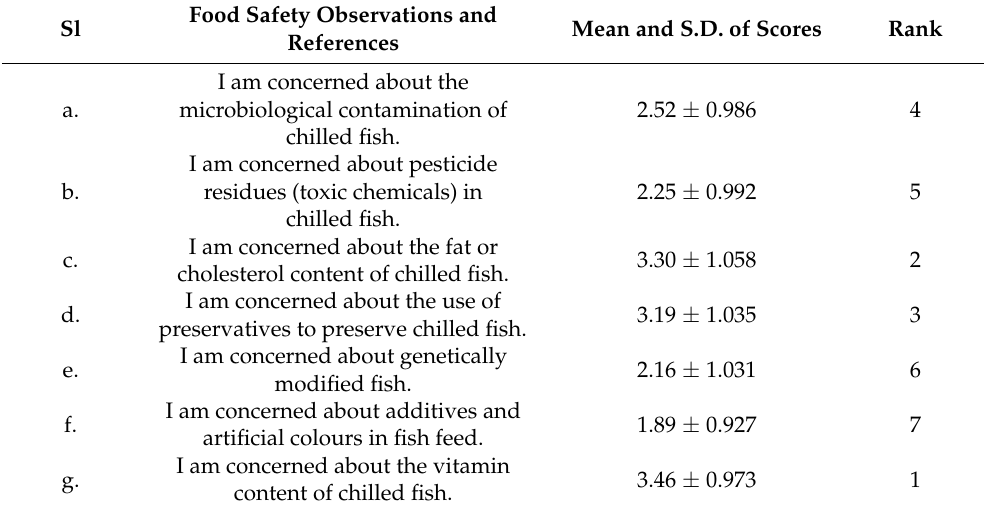
Table 2. Descriptive statistics of consumers’ food safety concerns derived from the elicitation